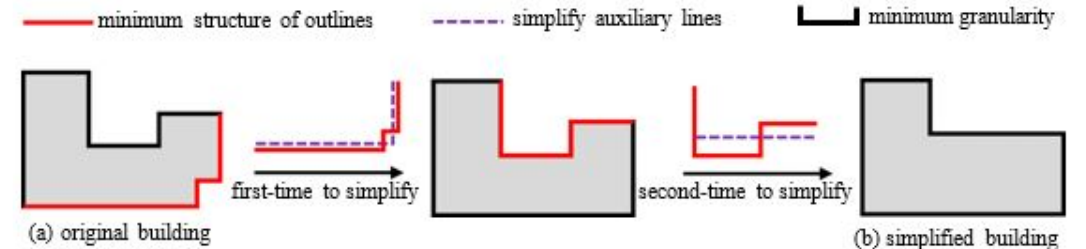
Figure 1. The basic idea of the proposed method.